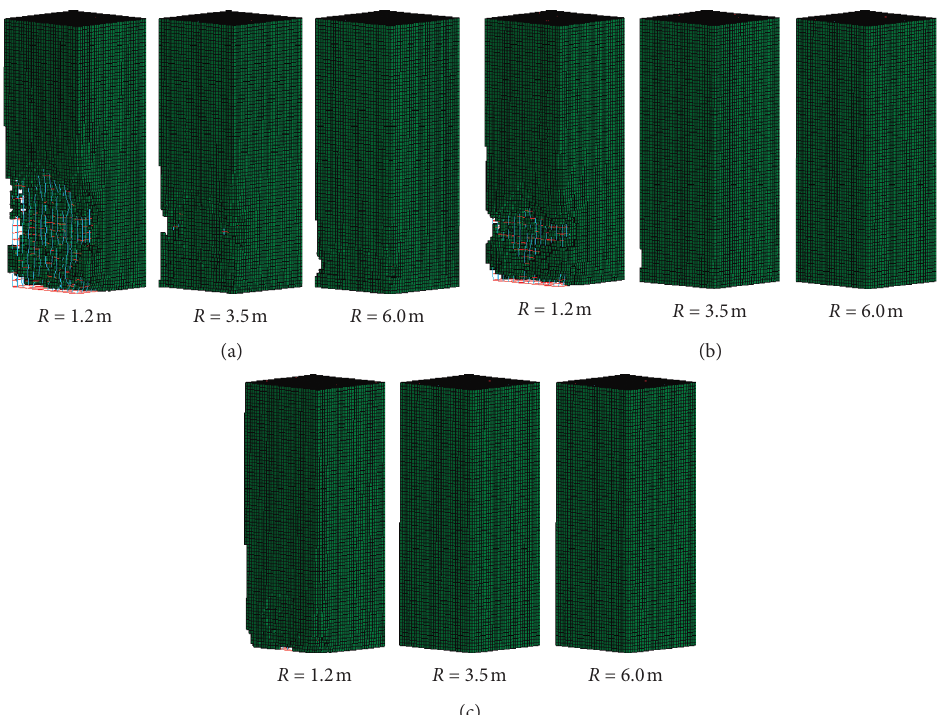
Figure 7: Several damage states of the pier under three types of car bombs: (a) 1# car bomb ( M � 1000kg, H � 1.0m), (b) 2# car bomb